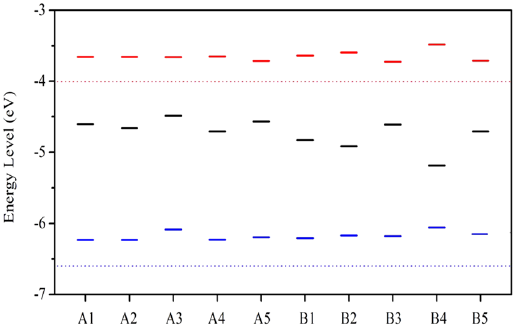
Figure 4. The calculated energy levels (in eV) including conduction band (red), Fermi level (black) and valence band (blue) of most stable five configurations for both dyes A and B. The dashed lines represent the pristine TiO 2 .